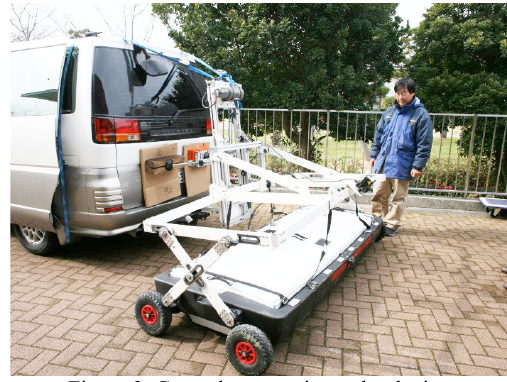
Figure 2. Ground-penetrating radar device